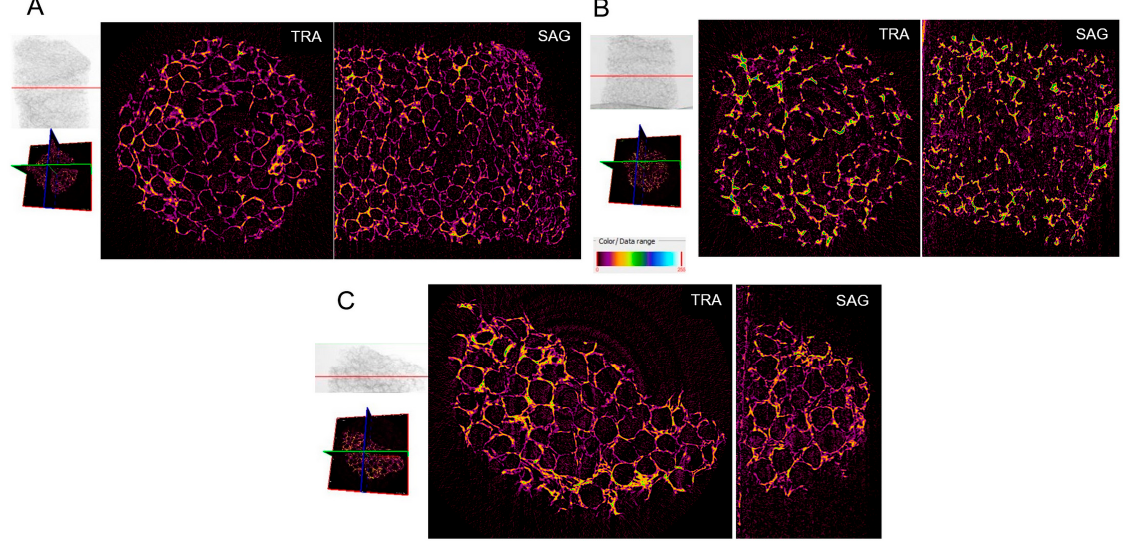
Figure 3. Micro-CT images of the total volume of all the samples in transaxial (TRA) and sagittal (SAG) views: ( A ) SSF; ( B ) SSFtime; ( C ) SSFc.